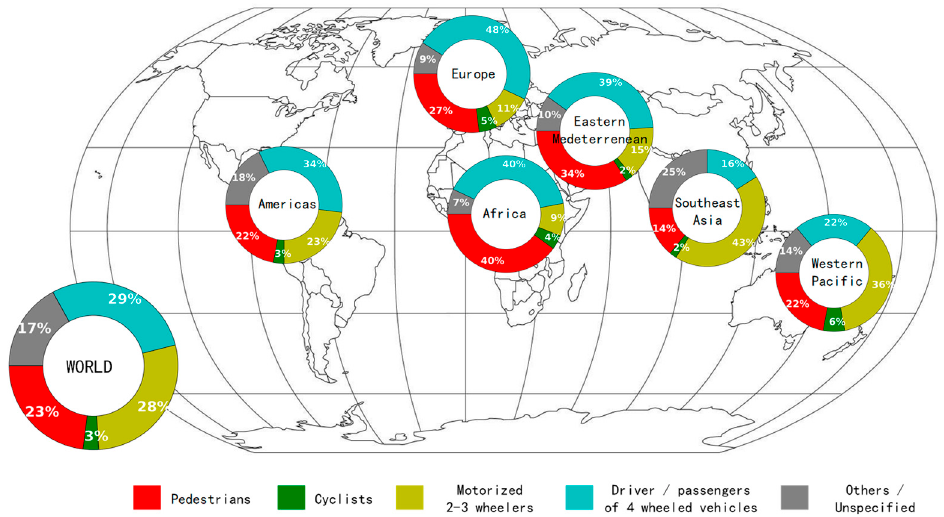
Figure 1. Distribution of deaths of road users in 2018 reported by the World Health Organization (WHO).